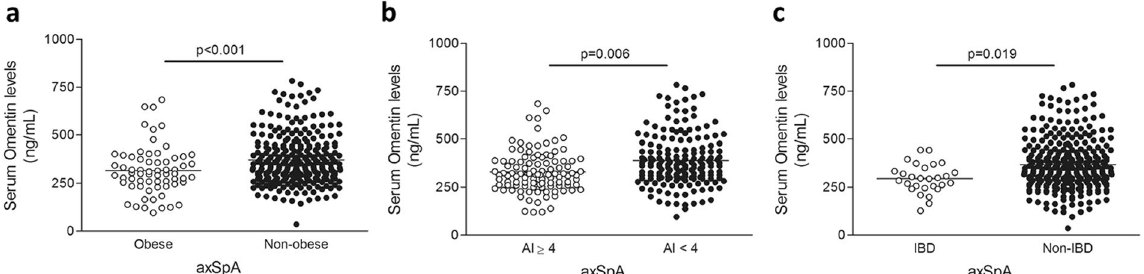
Figure 2. Omentin serum levels and cardiovascular risk factors. Differences in serum omentin levels between obese and non-obese axSpA patients ( a ), axSpA patients showing or not an AI indicative of dyslipidemia (AI ≥ 4) ( b ), and axSpA patients with and without IBD ( c ), after adjustment for potential confounding factors. Horizontal bars indicate the mean value of each group.